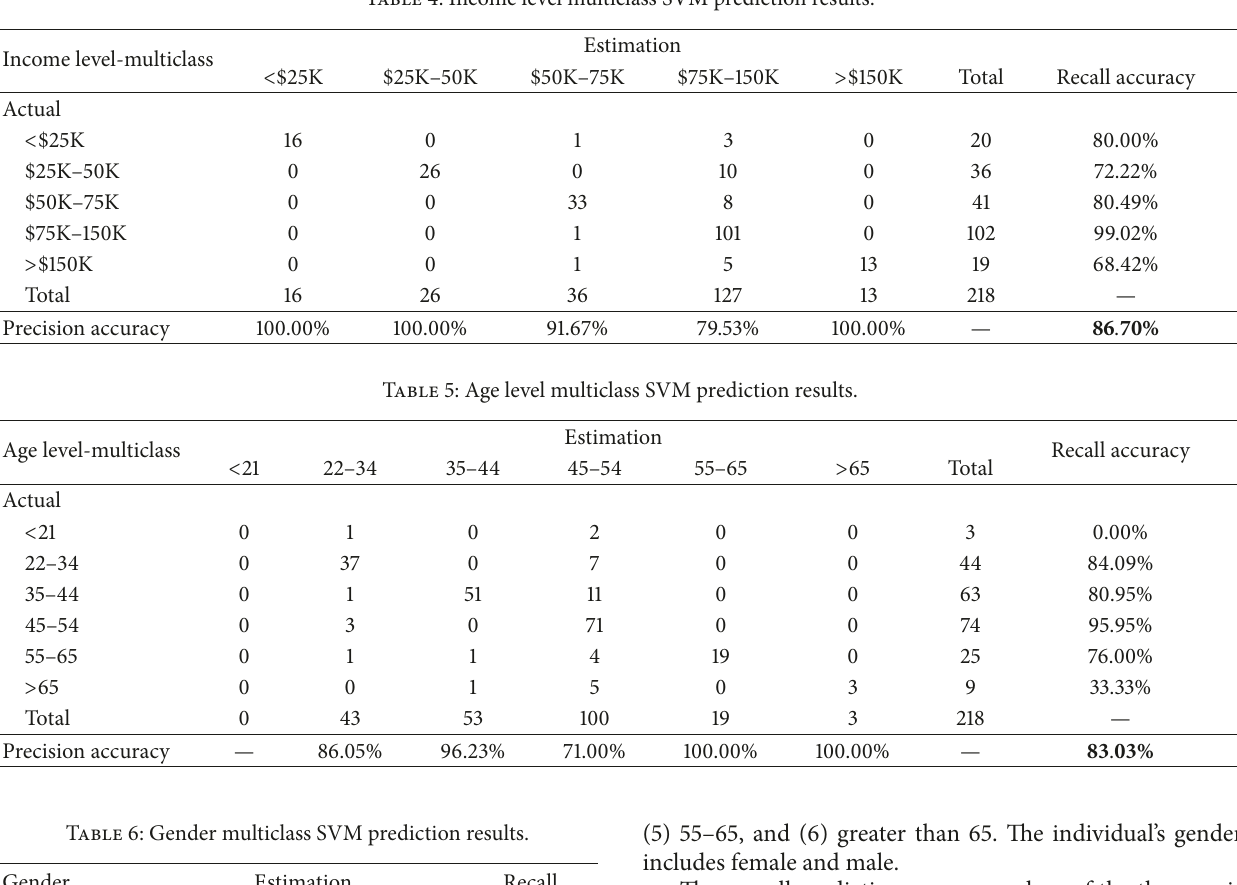
Table 4: Income level multiclass SVM prediction results.